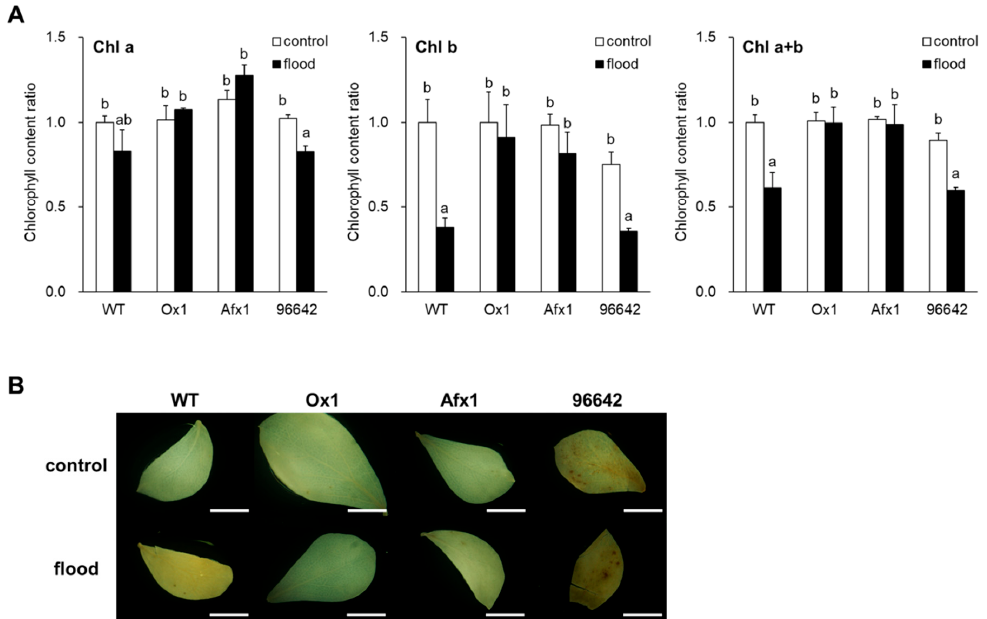
Figure 5. Relative chlorophyll content and ROS detection in flooded and unflooded (control) plants. ( A ) Absorbance of chlorophylls ( a , b , a + b ) dissolved in DMF. Chlorophyll content in the leaves of unflooded WT was set at 1. Values are means ± SE of three biological replicates, each with three technical replicates. Means denoted by the same letter do not differ significantly by Student’s t -test ( p < 0.05). ( B ) In situ hydrogen peroxide staining with DAB in leaves of flooded and unflooded plants. Scale bars, 5 mm.